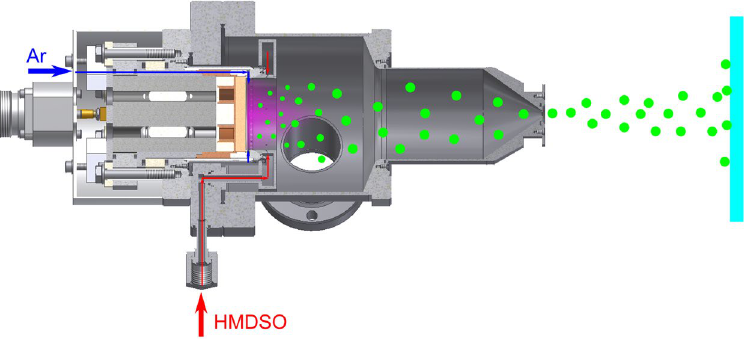
Figure 1. Schematics of the gas aggregation cluster source and the gas inlet